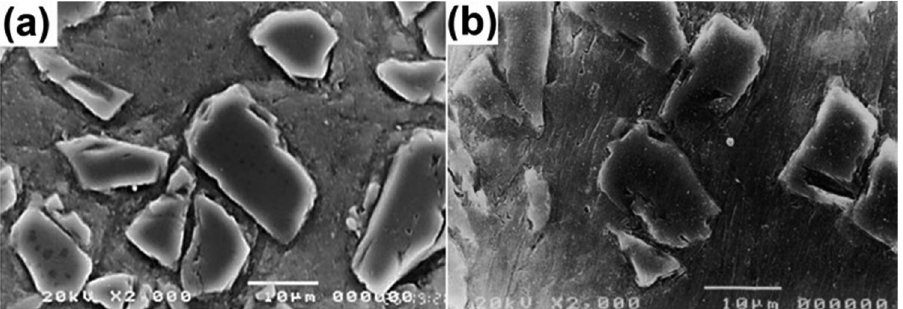
Figure 4: SEM images of an A359 + 20 vol% SiC particles AMC. ( a ) Before elevated temperature exposure, with SiC particles presenting relatively fl at surfaces and interfaces. ( b ) After being held at 650 C for 48 h, with SiC surfaces presenting pits and ledges ( Reproduced with permission from [ 89 ] . )